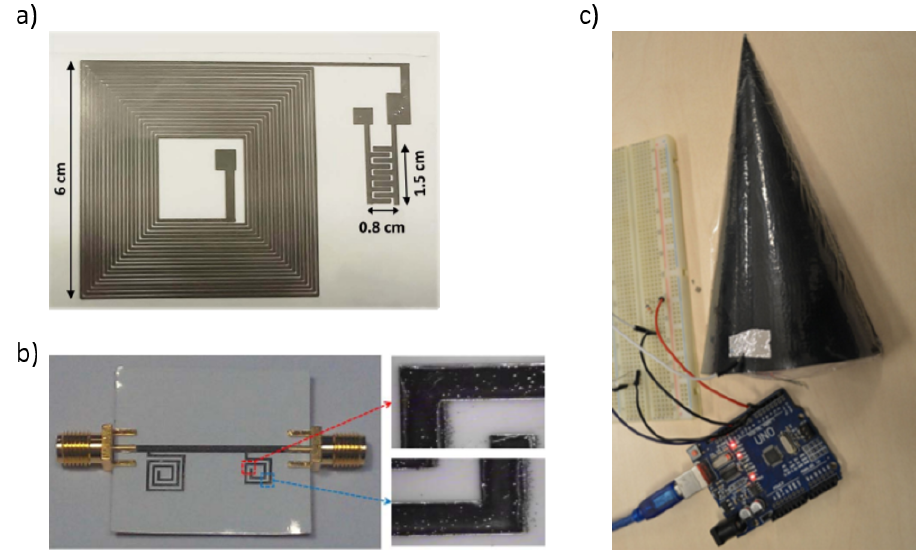
Figure 6. Inkjet-printed capacitive sensor layout on ( a ) PET substrate [129]. ( b ) Photopaper [130]. ( c ) TPU substrate